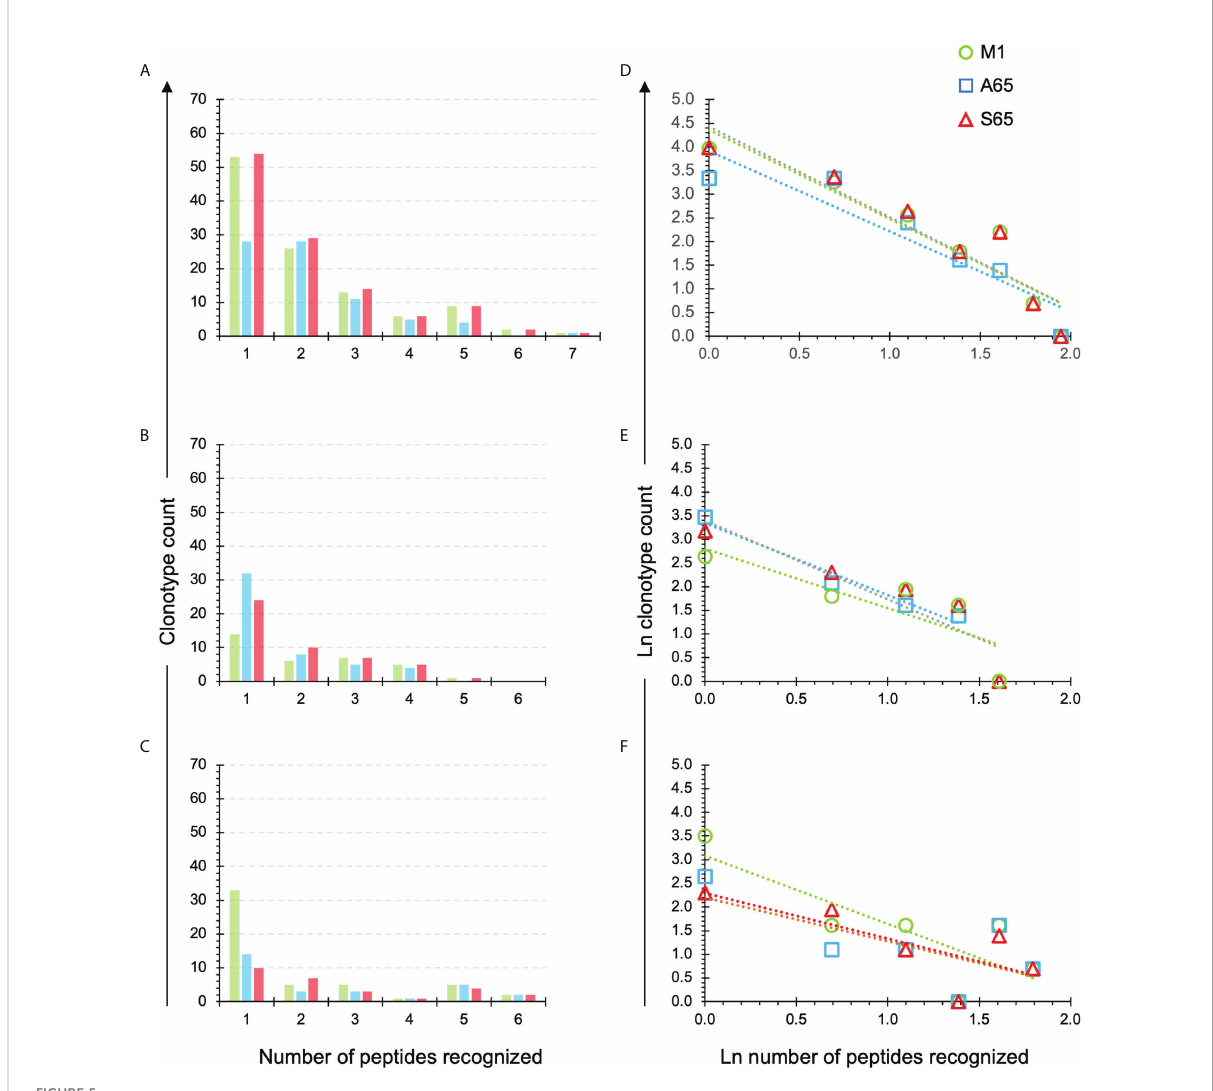
FIGURE 5 Extent of cross-reactivity of clonotypes in the M1, A65, and S65 repertoires. The repertoires are identi fi ed by color. (A – C) correspond to the eponymous donors and show the counts of the M1, A65 or S65 reactive clonotypes that recognize one or more peptides. The number of peptides recognized is shown on the x-axis. An x value of one represents the non-cross-reactive repertoire. A value of seven represents a clonotype that was present in all repertoires. (D – F) show ln rank vs. ln rank-frequency plots of the data in (A – C) respectively. Details of the power law-like component are provided in Supplemental Tables S4 and S5 aggregated by donor or peptide respectively. Average values from the Supplemental Tables are in Tables 3, 4